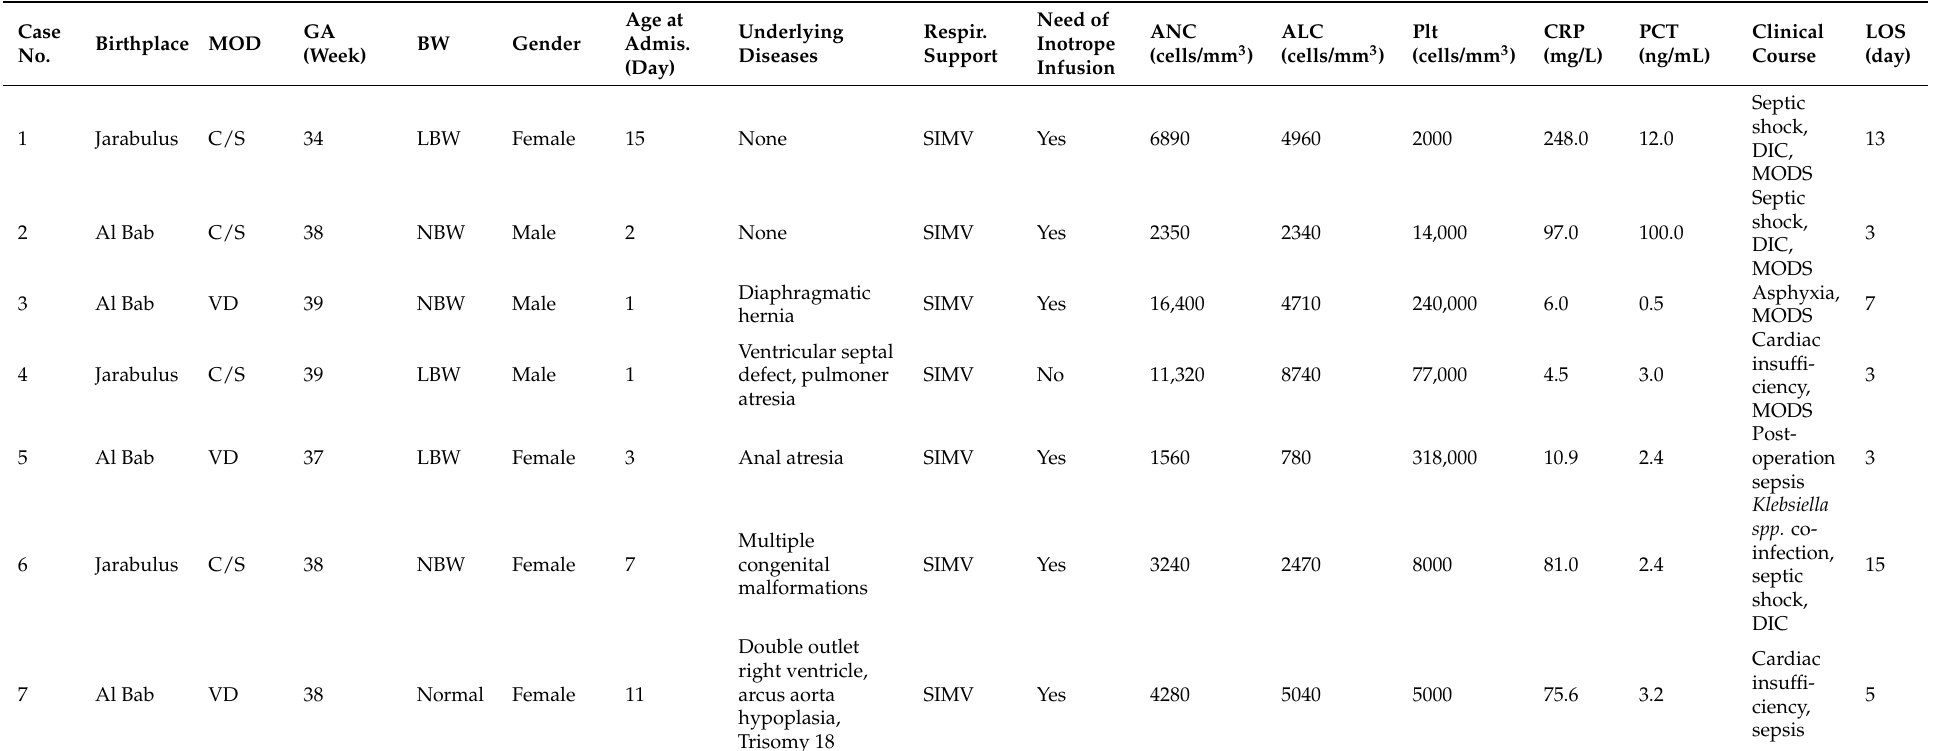
Table 3. Characteristics of the non-survivor neonates with Burkholderia cepacia complex